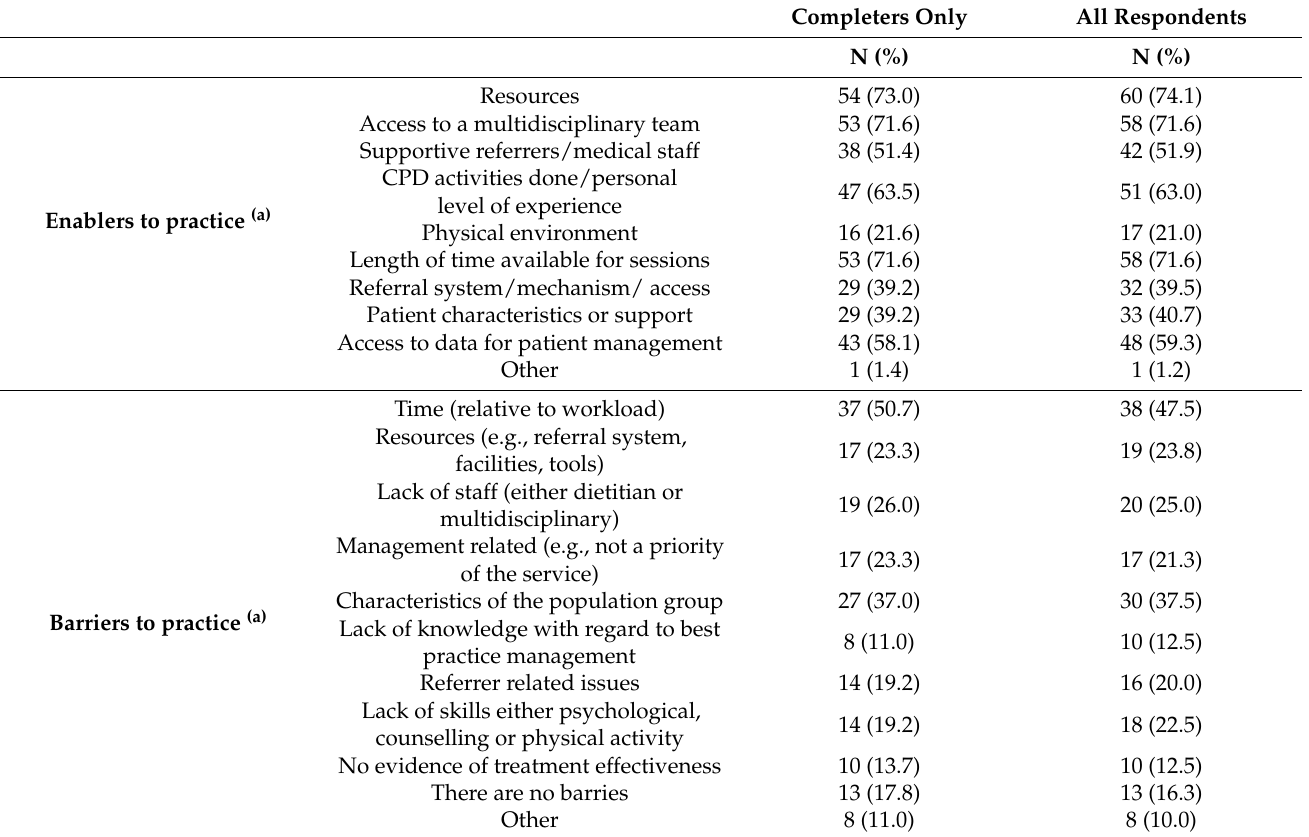
Table 3. Barriers and Enablers to